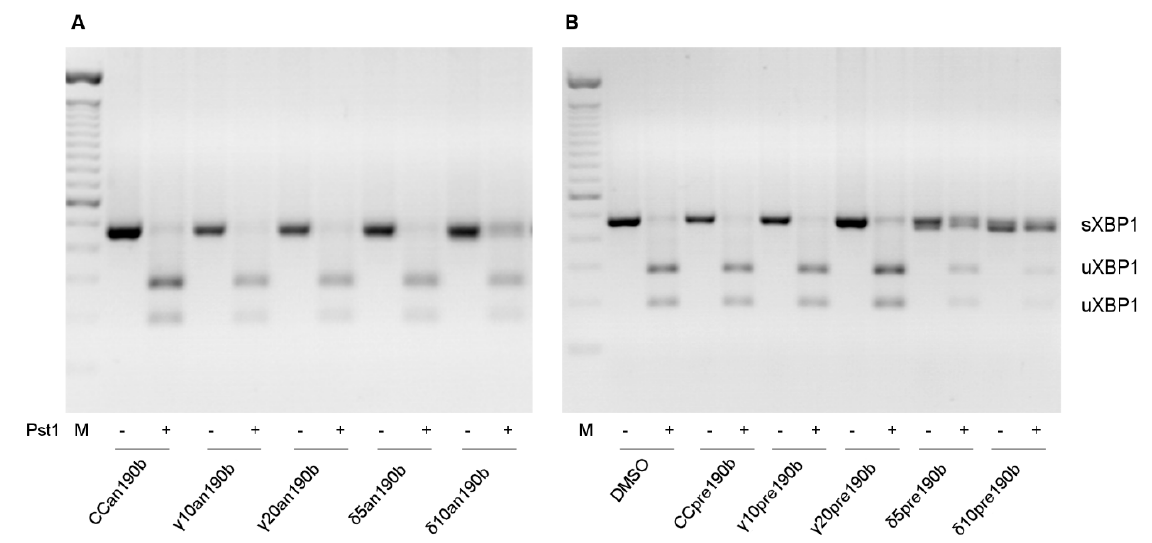
Figure 2. Xbp1–mRNA alternative splicing. Effects of γ T3 (10 or 20 µg/mL for 24 h) and δ T3 (5 or 10 µg/mL for 24 h) on HeLa cells transfected with anti-miR-190b (Panel A , an190b) and pre-miR-190b (Panel B , pre190b) and on mRNA alternative splicing of Xbp1. CC, control cells. PCR amplicons were digested with PstI. Digested and not digested PCR products were resolved on 2% agarose gels, stained with EtBr. The figure shows 1 of at least 3 representative experiments.